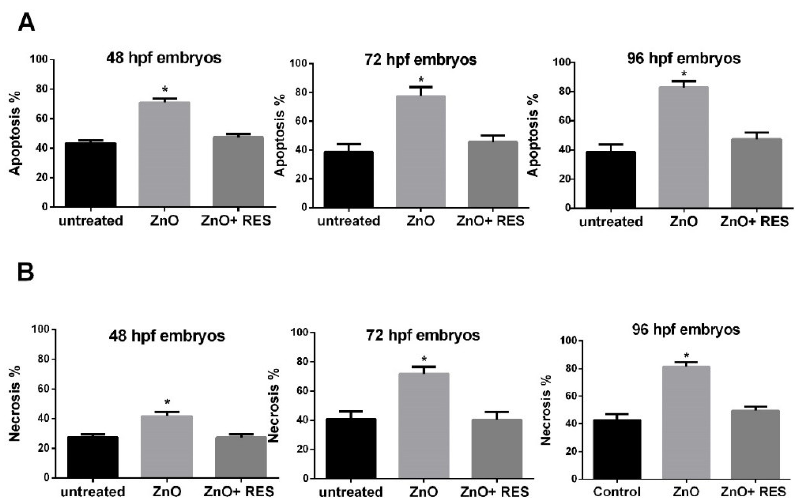
Figure 6. Resveratrol prevents ZnO NP-induced apoptosis and necrosis. ( A ) Percentage of apoptosis and ( B ) necrosis in 48, 72, and 96-hpf zebrafish embryos. Twenty four-hpf embryos were treated with 3 mg/L ZnO in the absence (ZnO) and presence (ZnO + RES) 5 μM resveratrol before proceeding with AO/PI double staining for apoptosis/necrosis quantification. Fluorescence was measured at the indicated hpf with a GENios plus microplate reader using a wavelength of 485 (excitation)/535 (emission) for AO and 493 (excitation)/632 (emission) for PI. RES, resveratrol. Values are shown as mean ± SD, n = 5. *, significantly different from untreated.